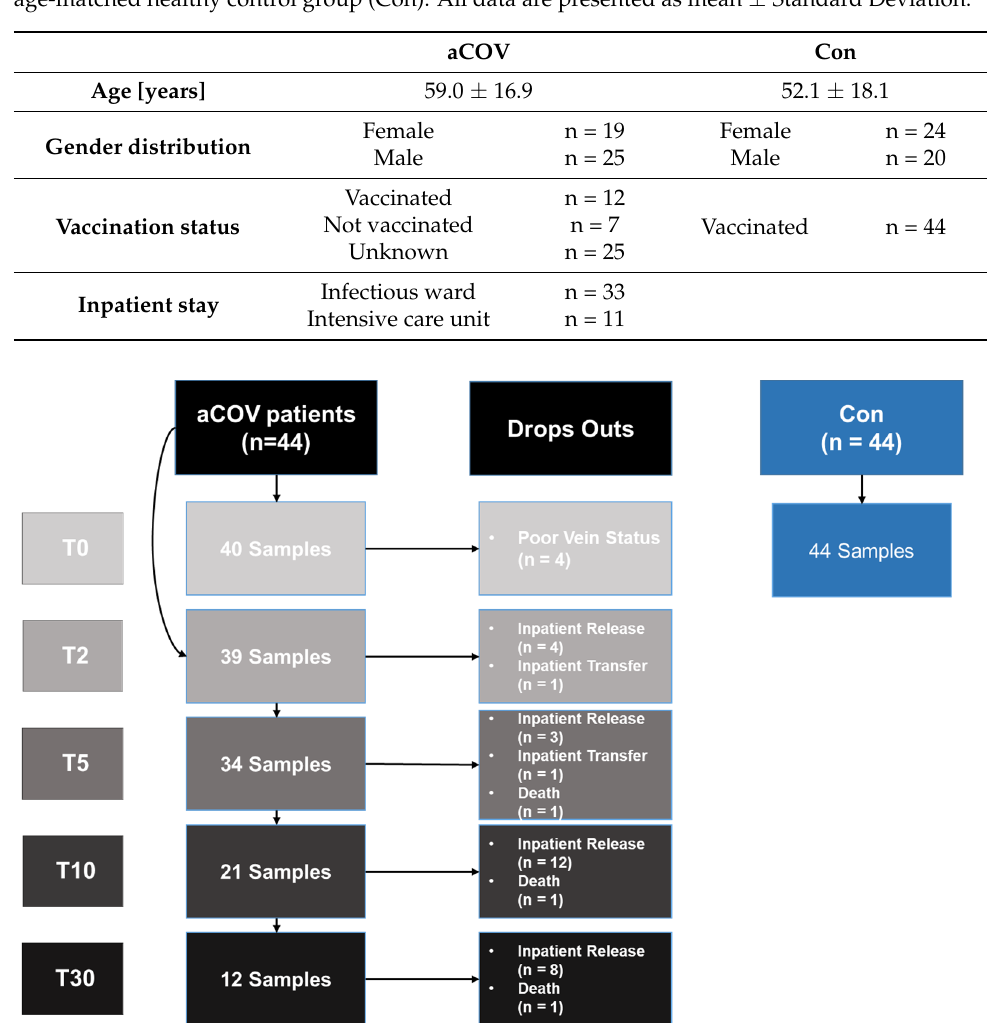
Figure 1. Blood sample collection from the COVID-19 patients (aCov) and the healthy control group (Con) at the respective time point (i) acute/admission (T0), (ii) day two (T2), (iii) five (T5), (iv) ten (T10) and (v) thirty (T30) after admission. Sample number decreased during the study due to poor vein status, inpatient release/transfer, or death (Drop-Outs). In detail, some patients were lost due to patient inaccessibility after inpatient release/transfer (non-cooperating hospital/physician; inability to travel to the hospital again after patient release at the respective definite time points). The majority sampling time points after hospital admission. Some of the 44 included samples were collected for the first time at T2, explaining the number discrepancy between T0 and T2. Con samples were collected once